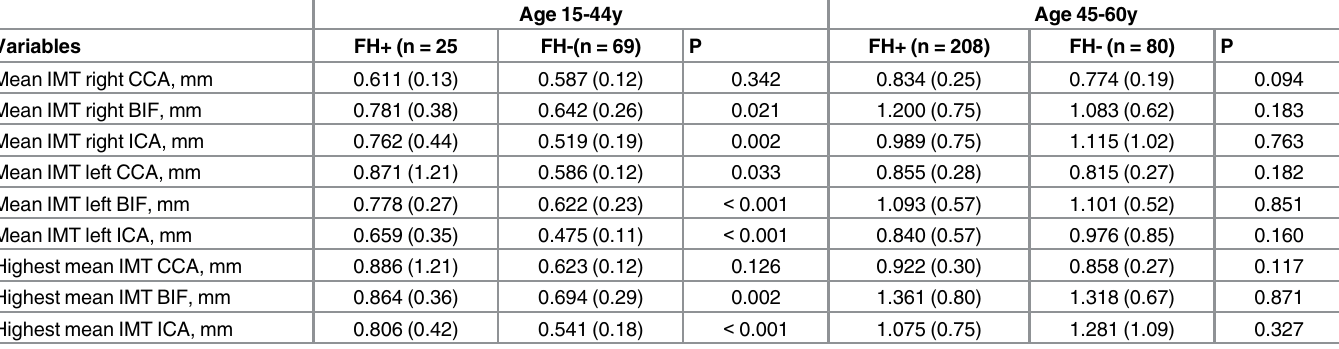
Table 2. Ultrasound measurements of the segmental carotid intima-media thickness in 382 young and middle-aged patients included in the Stroke in the Young Study (NOR-SYS) in Bergen, Norway 2010 –